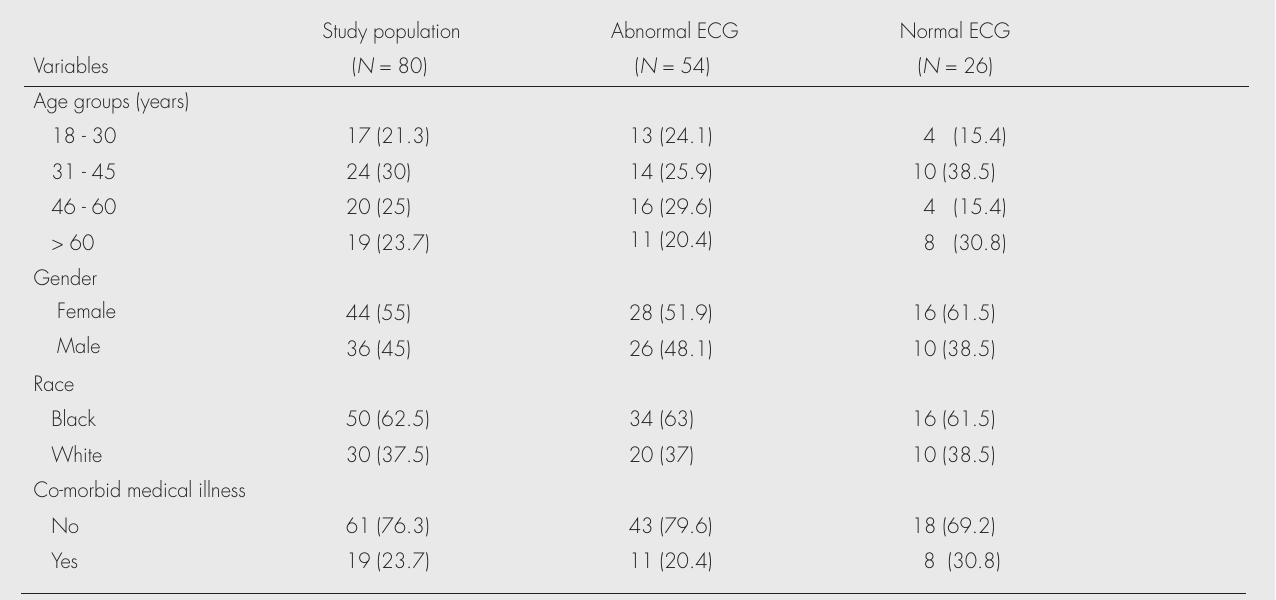
Table I. Characteristics of the total patient sample (N (%))